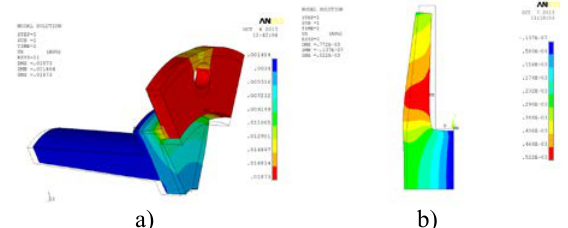
Fig. 14. Radial movements in mandrel (a) and spindle (b). This movement causes the tightening to be